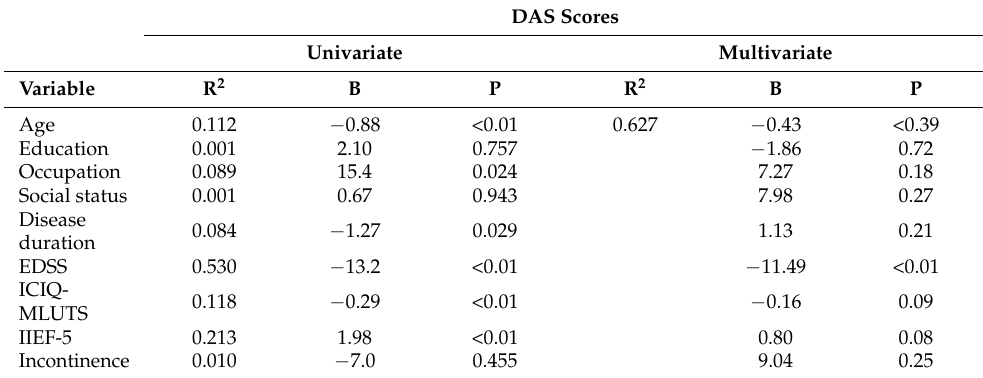
Table 2. Univariate and multivariate linear regression analysis for DAS